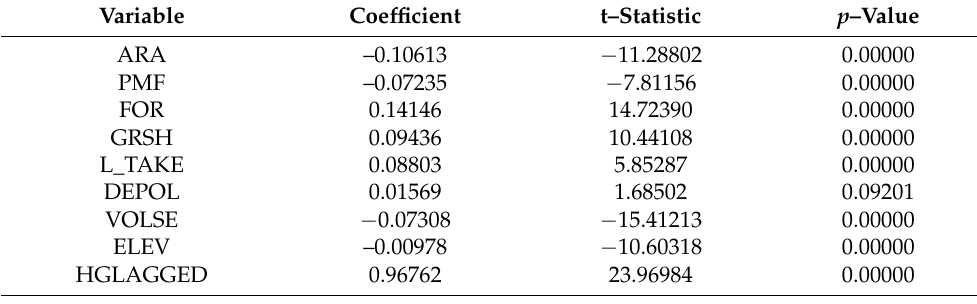
Table 5. Estimate of regression model